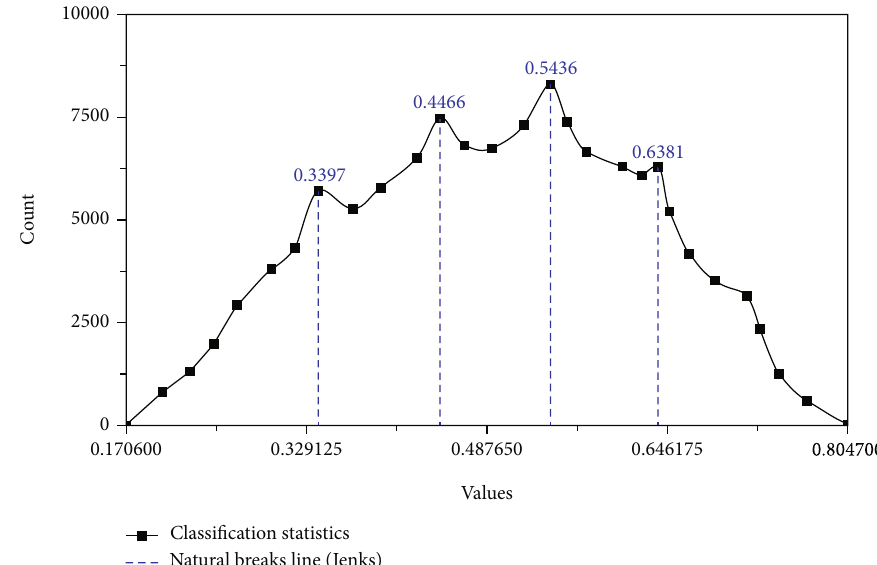
Figure 3: The classi fi cation of natural breaks.